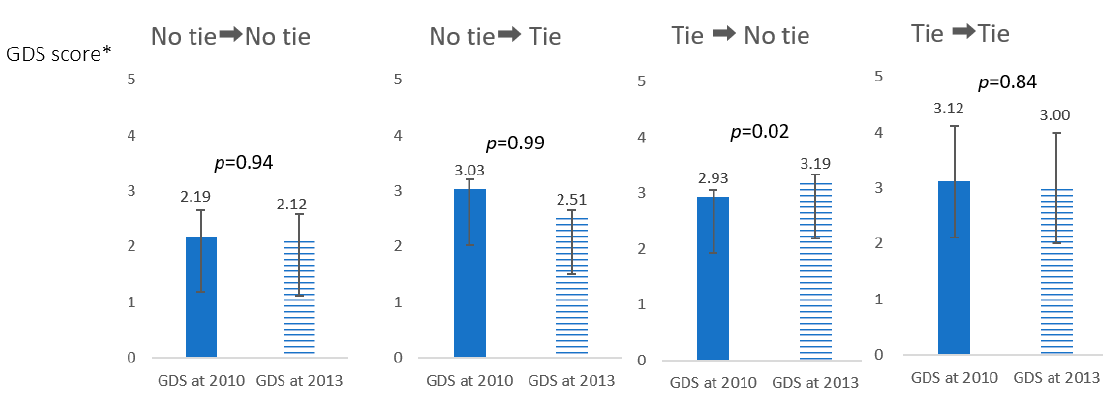
Figure 2. Change of Mean Geriatric Depression Scale (GDS) score from 2010 to 2013. * GDS score is up to 15 scores. The higher the score, the more depressed. Means of GDS and standard deviations are presented.